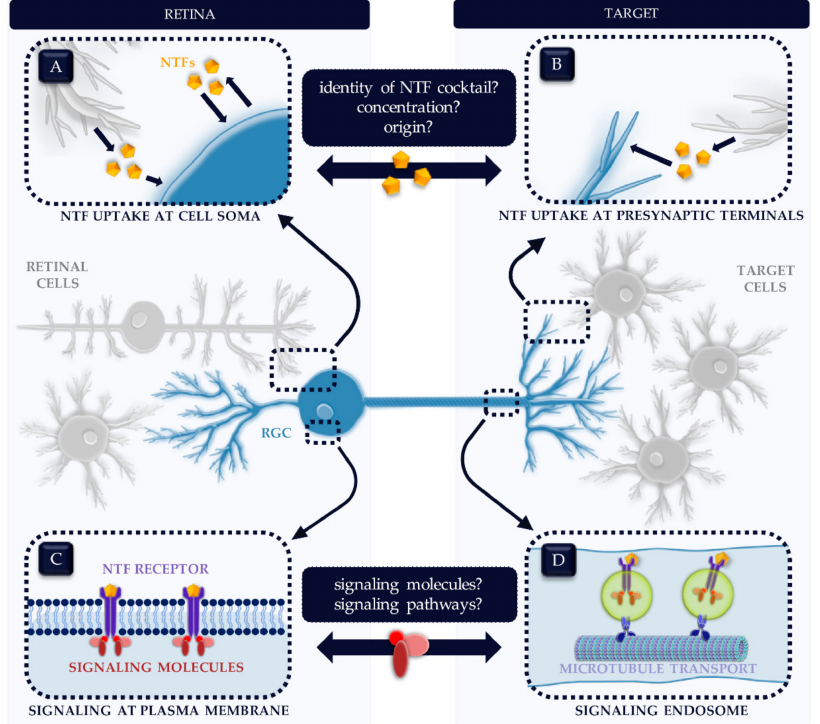
Figure 2. Gaps in the fundamental knowledge of neurotrophic factors (NTFs) in the adult visual system. ( A , B ) Many fundamental questions regarding the NTF cocktail essential for retinal ganglion cell (RGC) survival remain unanswered. Precisely which NTFs are involved? Is the interplay between two or more NTFs a bare necessity? If so, what is the ideal ratio of each NTF in the cocktail? Do vital NTFs originate from local sources or from target areas, or both; and from which specific cell type—i.e., neurons and / or glial cells? ( C , D ) Also on cellular level, a number of research questions are yet to be unraveled regarding the NTF mechanism of action. How do NTFs function upon receptor binding? What is the complete array of involved signaling molecules and pathways? ( A , C versus B , D ) All of the abovementioned parameters might di ff er depending on the site of NTF presentation: at the cell soma ( C ) or at the presynaptic terminals ( B , D ). For example, recruitment of downstream signaling molecules varies upon the location where the signaling machinery is switched on: the cell soma for retinal NTFs ( C ) versus the distal axon for target-derived NTFs ( D